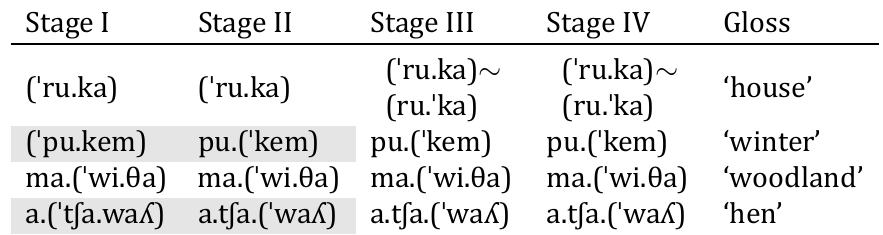
Table 18: Changes in nominal stress in di- and tri-syllables: vowel and consonant (cid:976)inal (feet in parenthesis — key changes in grey)